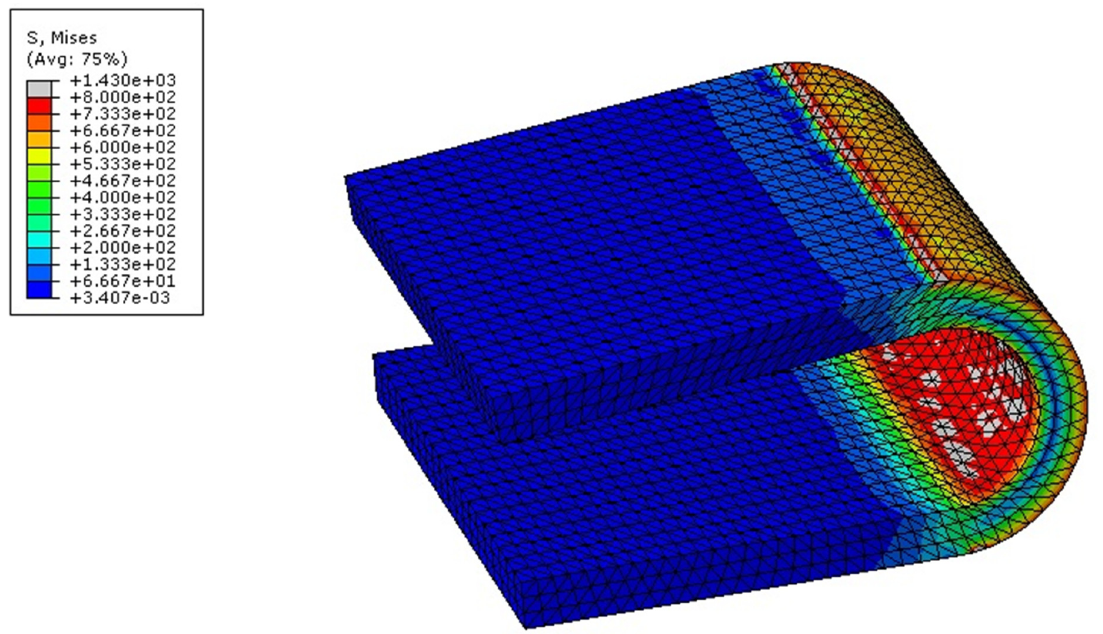
Figure 8. Maximum stress distribution in the U-shaped implant (DCI) during flexion in the C4–C6 DCI model. DCI